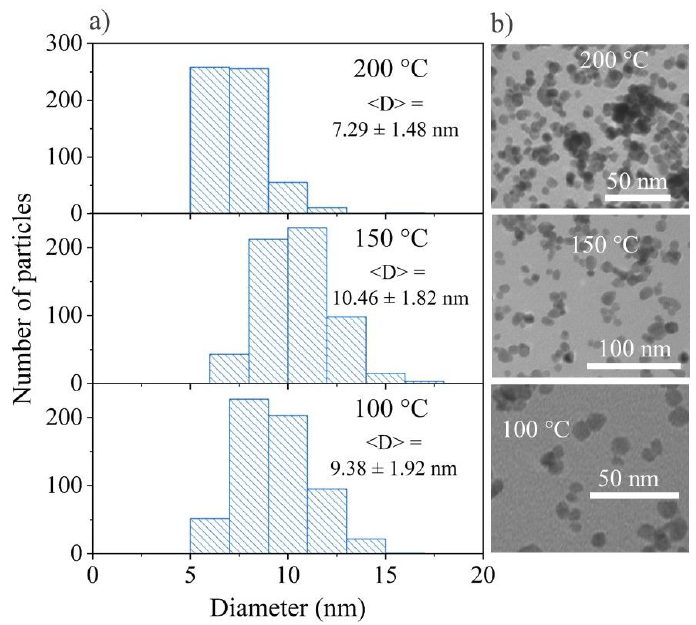
Figure 6. ( a ) Particle size distribution and <D> with the mean size ± standard deviation; ( b ) TEM images of 25Tb MW at 100 °C, 150 °C, and 200 °C.